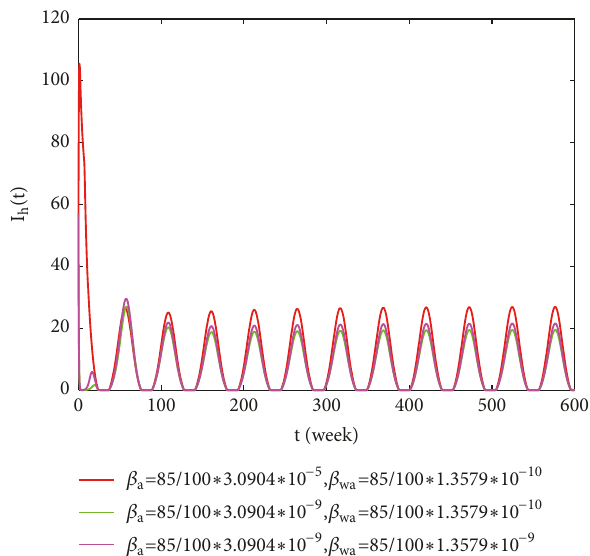
Figure 8: The curve-trend diagram of 𝐼 ℎ with time, when 𝛽 𝑎 or 𝛽 𝑤𝑎 takes different